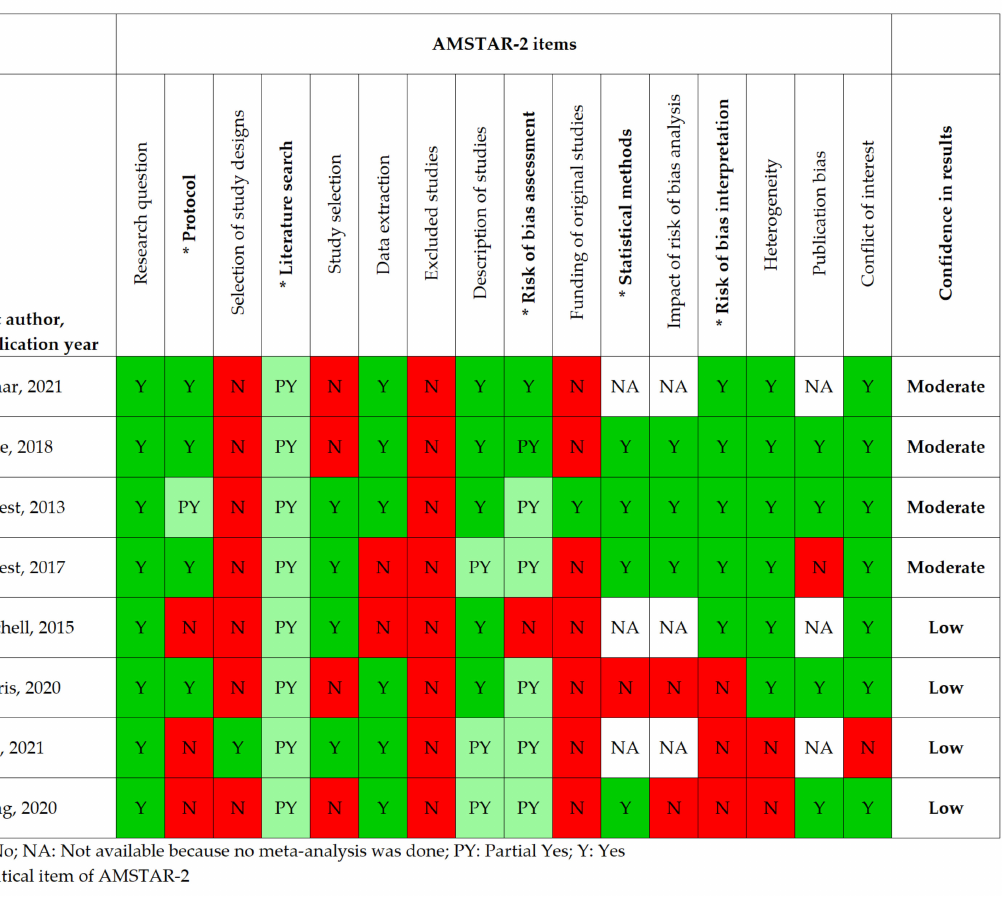
Figure 2. Risk of bias ratings for each item of the